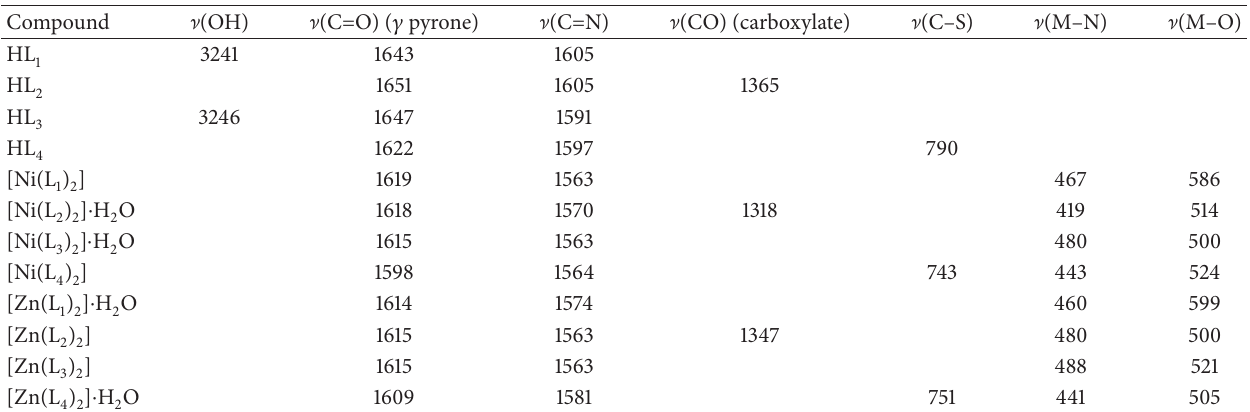
Table 2: IR spectral data of ligands and their metal complexes (cm − 1